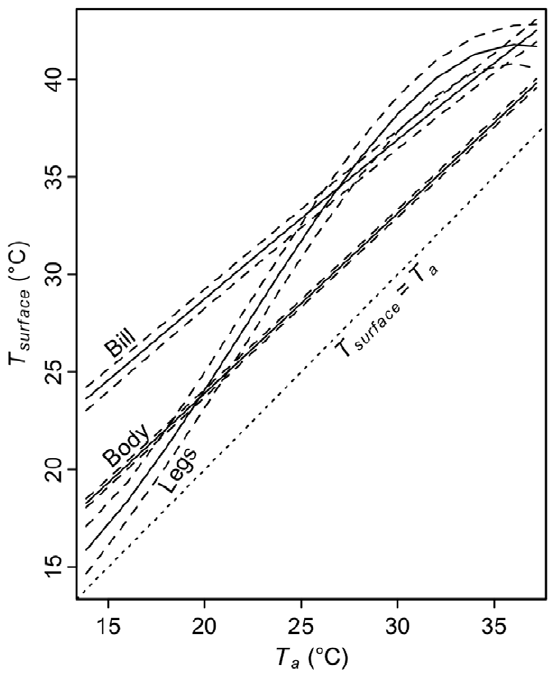
Figure 2. Surface temperature of bill and bill base of song sparrows vs. ambient temperature ( T a ). (A) shows values for bill and (B) presents values for bill base. Black lines=model averaged predictions of linear mixed models 6 highest and lowest unconditional standard errors. Gray lines=raw data.